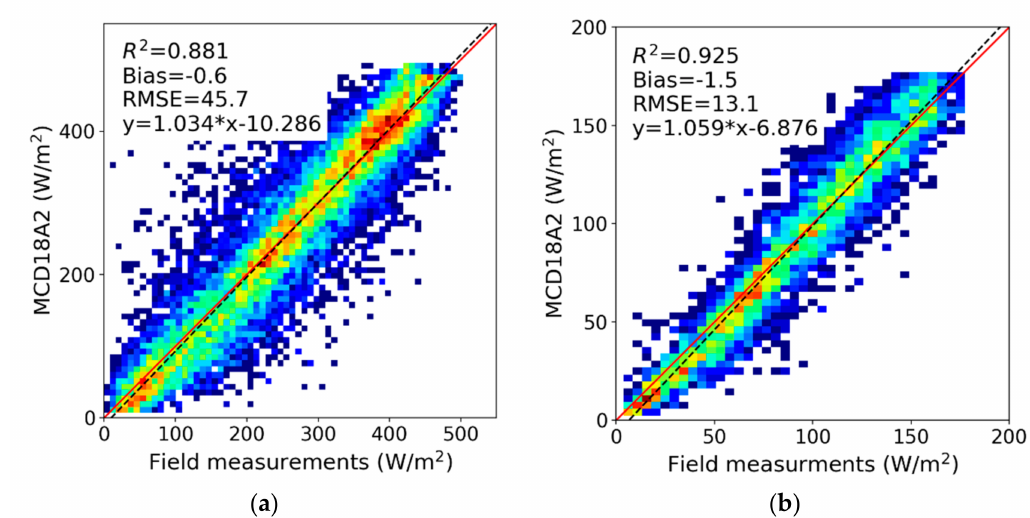
Figure 10. Validation results of the MCD18A2 PAR product using the AmeriFlux 2018 measurements for ( a ) instantaneous and ( b ) daily